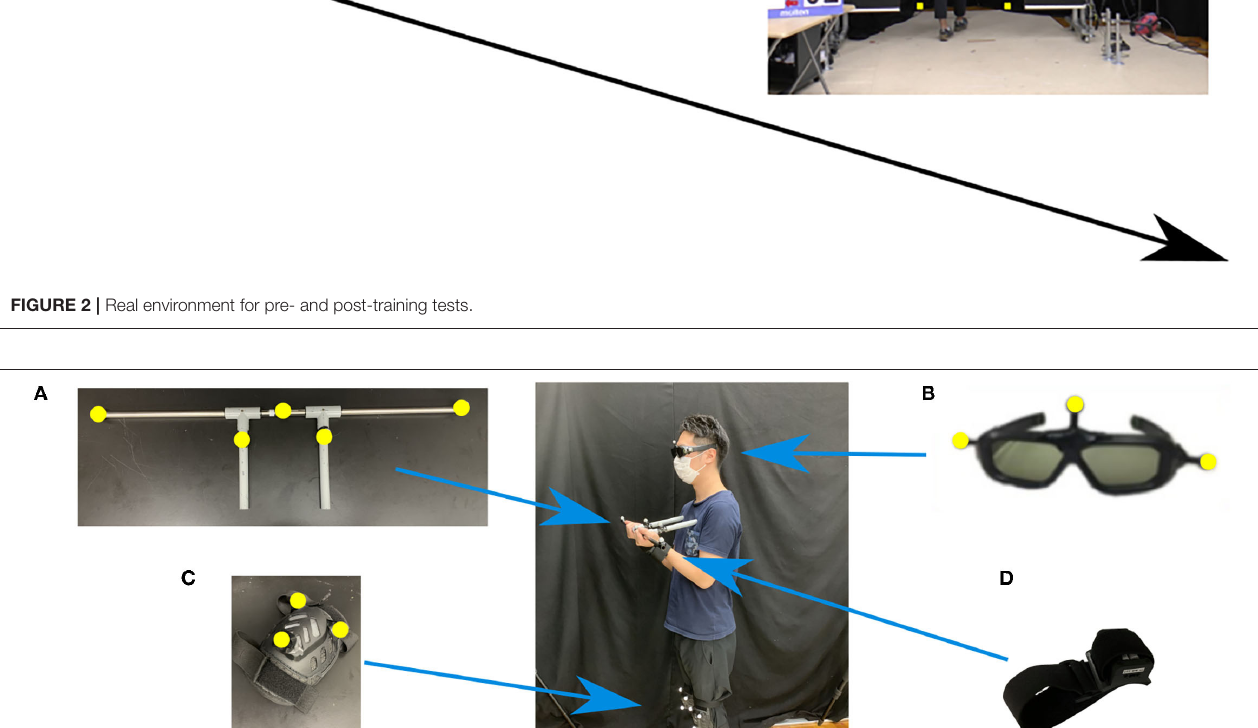
FIGURE 3 | Marker setup and equipment: (A) horizontal bar, (B) stereo shutter glasses, (C) knee pad, and (D) vibration stimulator. Yellow markers show reflexive